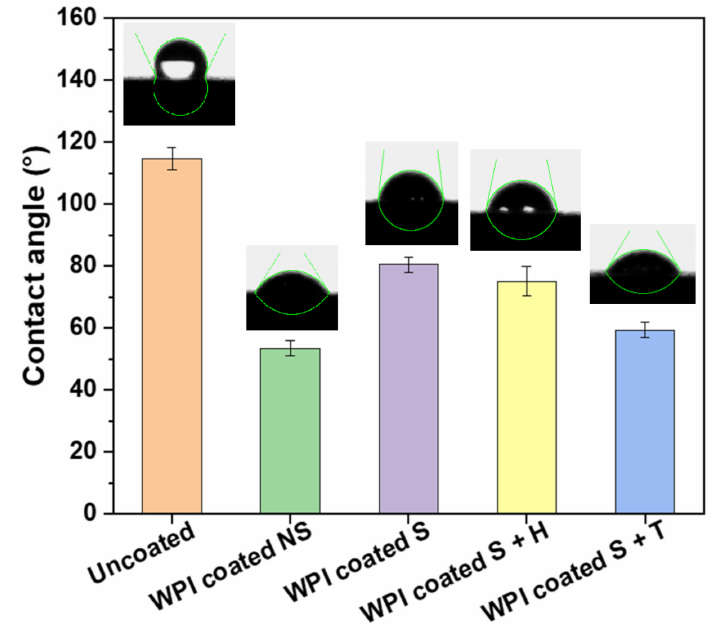
Figure 3. Contact angle measurements of Ti6Al4V discs: uncoated, coated with WPI fibrils at pH 2 not sterile (NS); coated with WPI fibrils at pH 2 and sterilized (S); coated and sterilized sample + heparin (S + H); coated and sterilized sample + tinzaparin (S + T). Error bars represent the standard